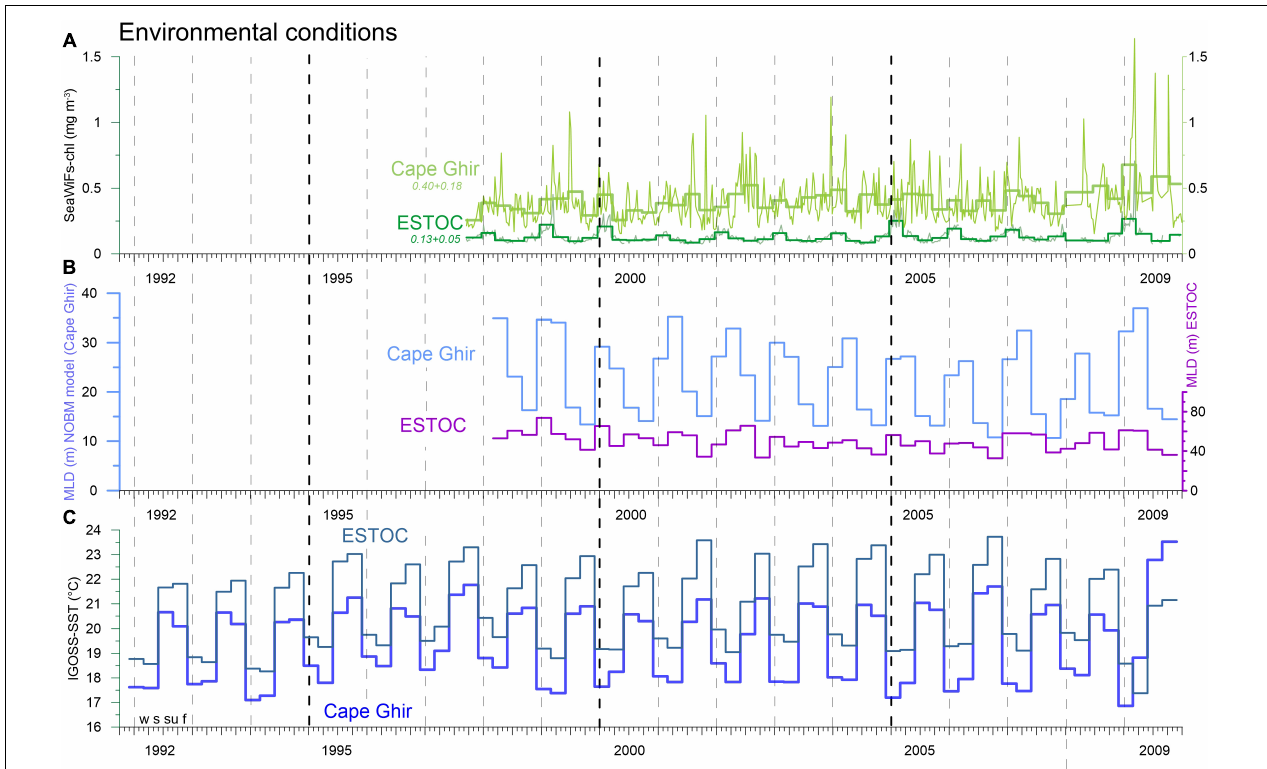
FIGURE 2 | Time series of major environmental variables. (A) Weakly and seasonal (DJF) SeaWiFs-chlorophyll (mg m − 3 ); seasonal (DJF), model-based MLD (m) (B) (NASA Ocean Biological Model, NOBM, from GIOVANNI); seasonal (DJF) IGOSS-SST ( ◦ C) (C) . Note the long-term increasing trend for chlorophyll at the coastal Cape Ghir filament box which is statistically significant. Vertical hatched lines indicate years (with the four seasons winter = w, spring = s, summer = su, fall = f; starting on Jan. 1), thick hatched lines indicate a 5-year mark.